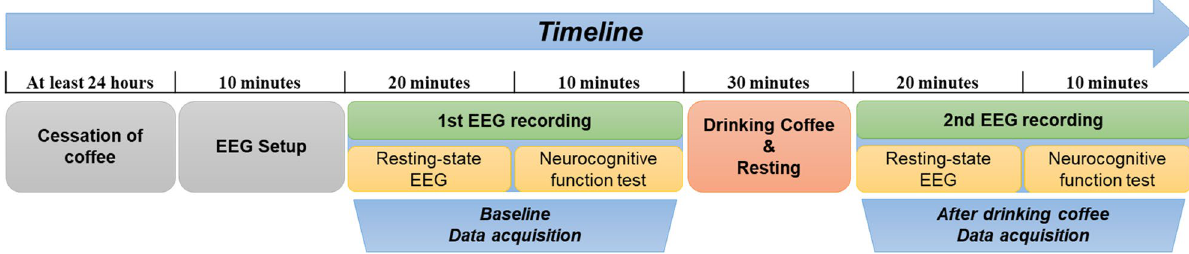
Figure 1. A diagram of the study protocol. The study protocol according to the timeline is presented